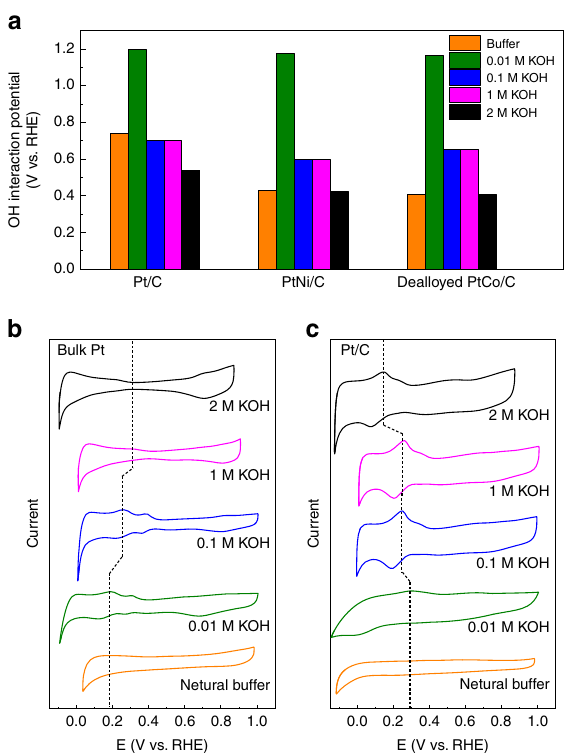
Fig. 4 The trends of H and OH interactions with different catalysts. a OH interaction potentials obtained for three catalysts in different electrolytes. Data obtained from CO stripping measurements. b , c CVs of bulk Pt and Pt/C in different electrolytes. The dotted line indicates the shifting trend of the H upd peak